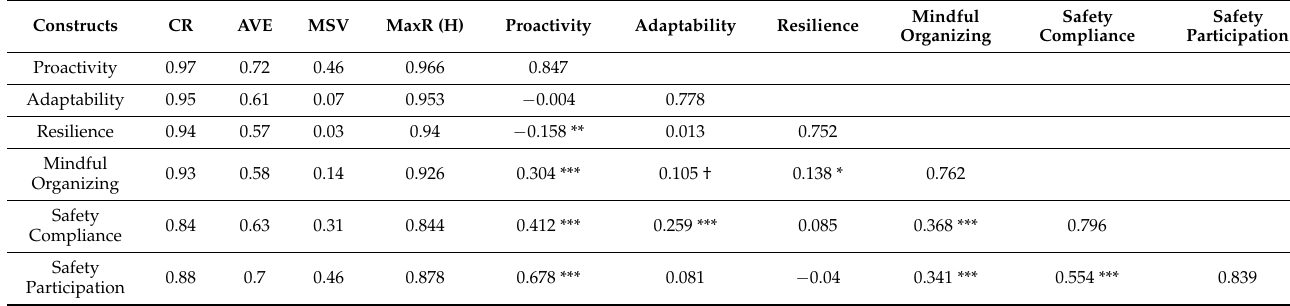
Table 2. Discriminant validity results.